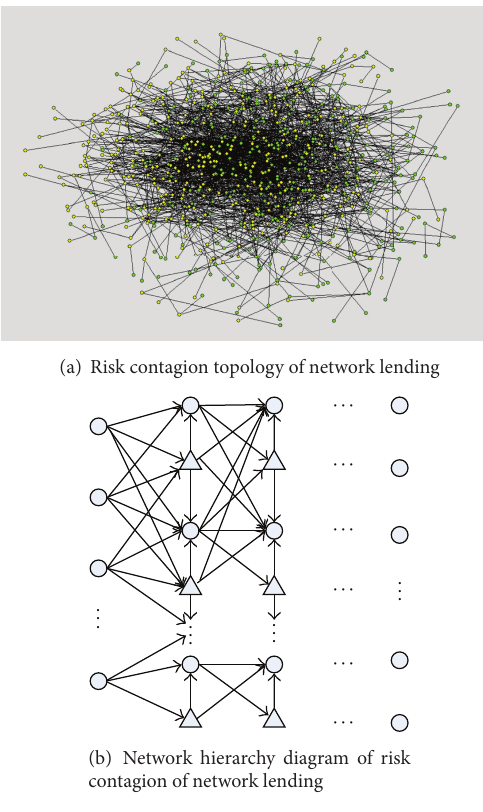
Figure 1: Risk contagion topology of network lending.